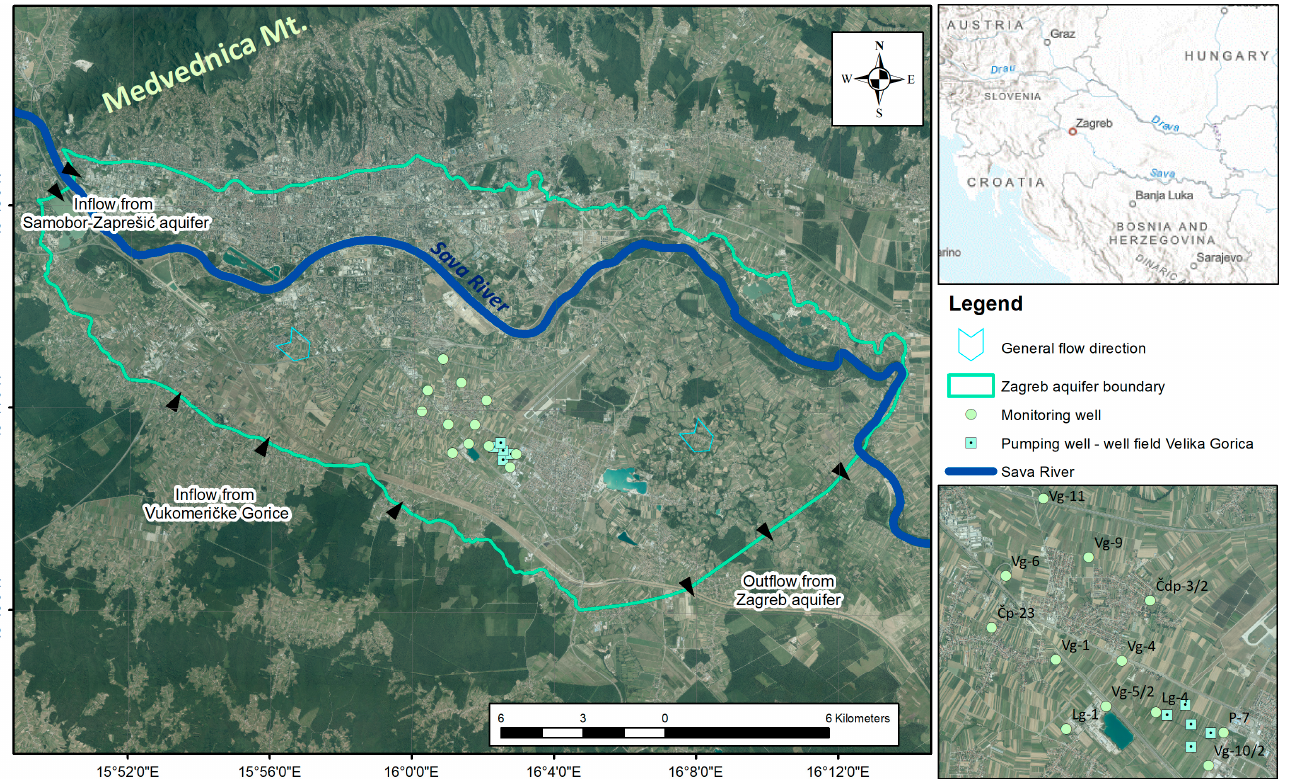
Figure 1. Research